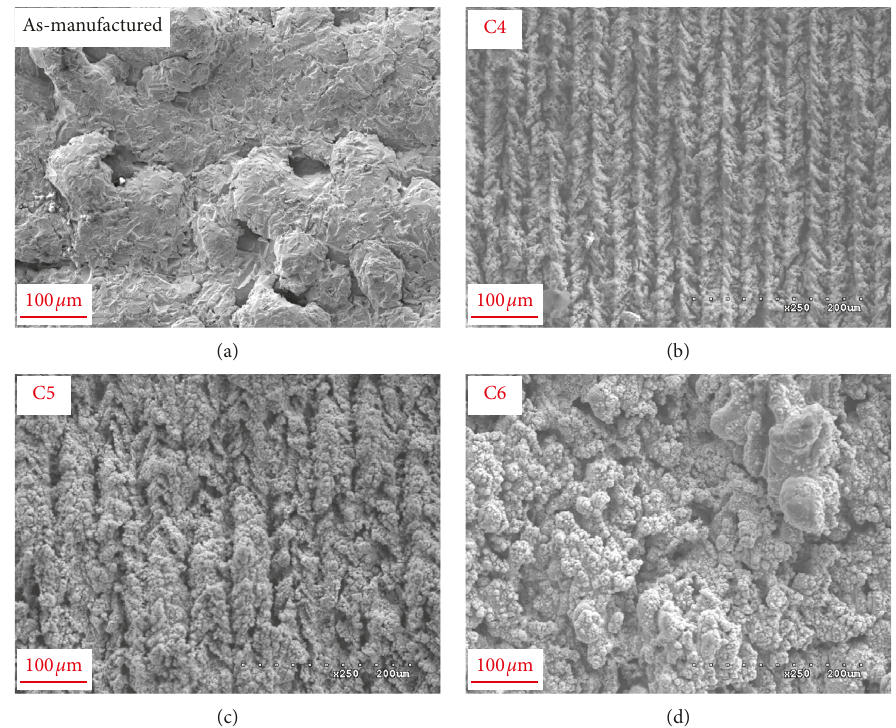
Figure 4: Comparison of as-manufactured surface morphology with morphologies obtained at different scanning speeds and constant power of 2.5W.